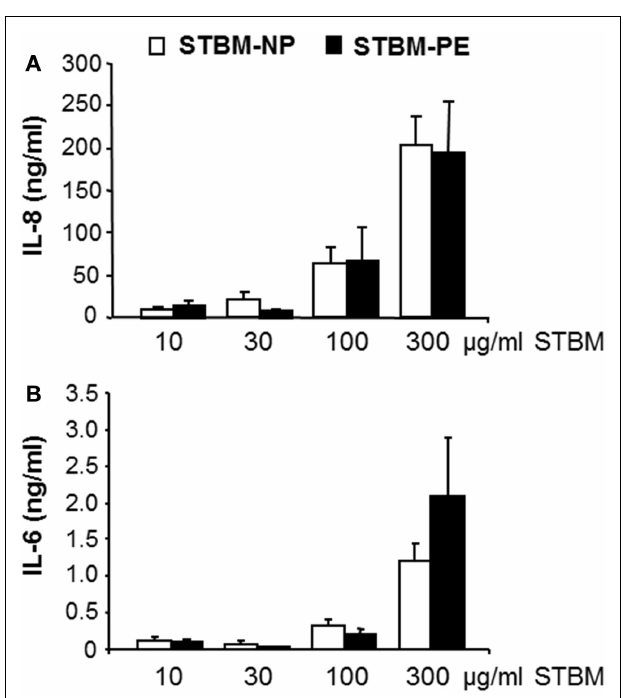
FIGURE 2 | STBM produced from normal and preeclamptic placentas induce a similar dose-dependent pro-inflammatory response in monocytes. Primary monocytes were incubated with increasing concentrations of STBM prepared from normal (STBM-NP) or preeclamptic (STBM-PE) placentas for 16h.The cellular secretion of IL-8 (A) and IL-6 (B) was measured by conventional ELISA. Results are illustrated as mean ± SEM of two independent monocyte co-culture experiments with five STBM-NP preparations and three STBM-PE preparations.There is no statistical difference between the responses generated by the two different STBM